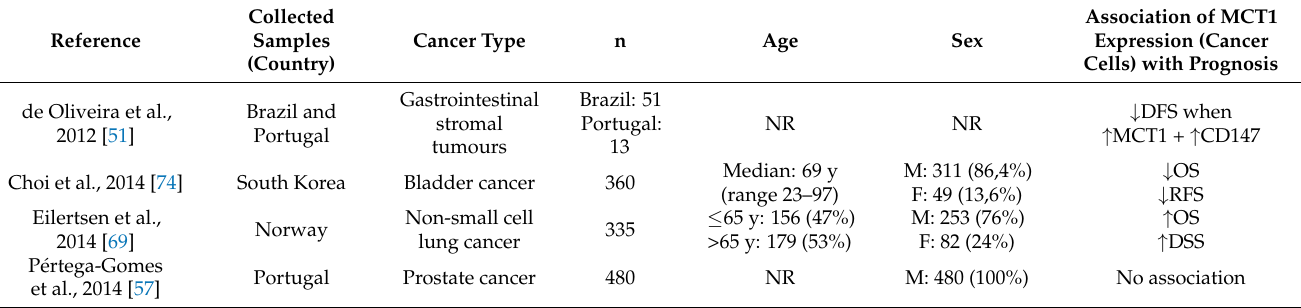
Table 1. The information included in the eligible studies regarding the characterisation of the population and association of MCT1 expression with